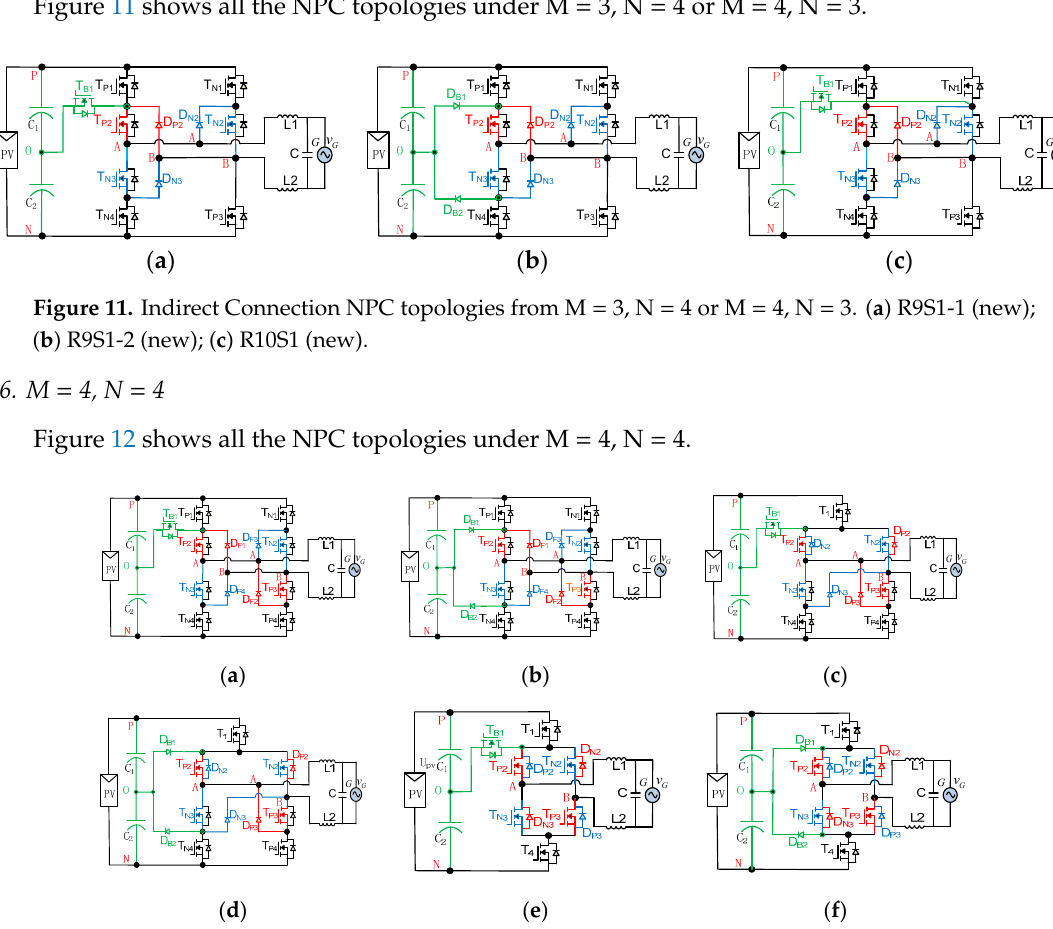
Figure 12. Indirect Connection NPC topologies from M = 4, N = 4. ( a ) R11S1-1 (new); ( b ) R11S1-2 (new); ( c ) R12S1-1 (new); ( d ) R12S1-2 (new); ( e ) R13S1-1 [49]; ( f ) R13S1-2 [49].